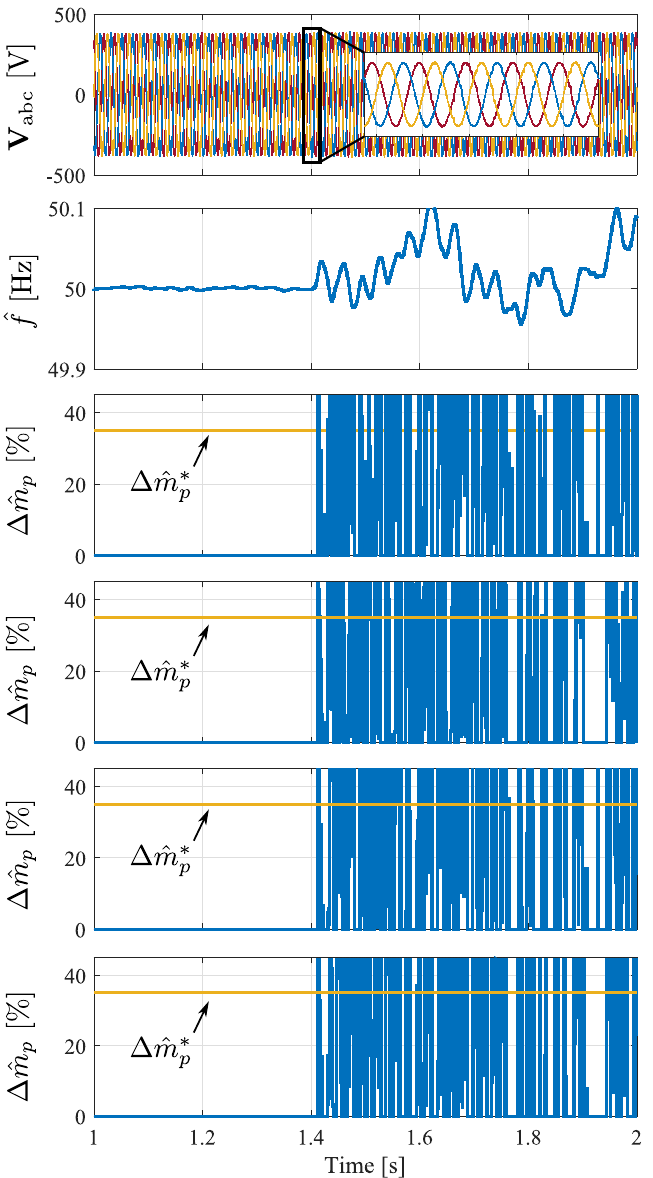
Figure 10. Case 5: Multiple DGUs test to check non-interference among DGUs